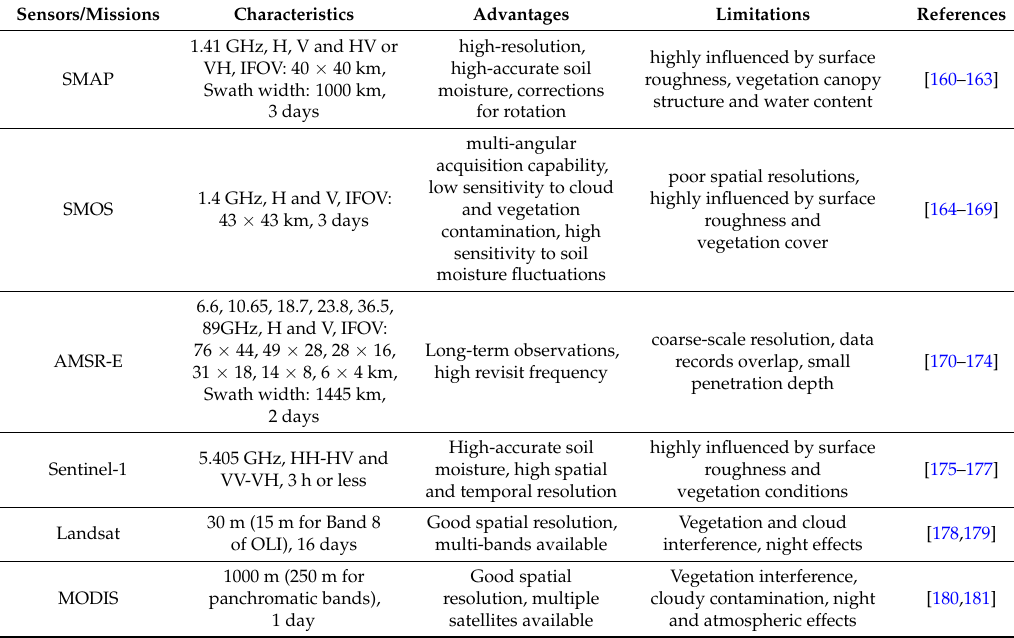
Table 4. Currently available soil moisture products by remotely